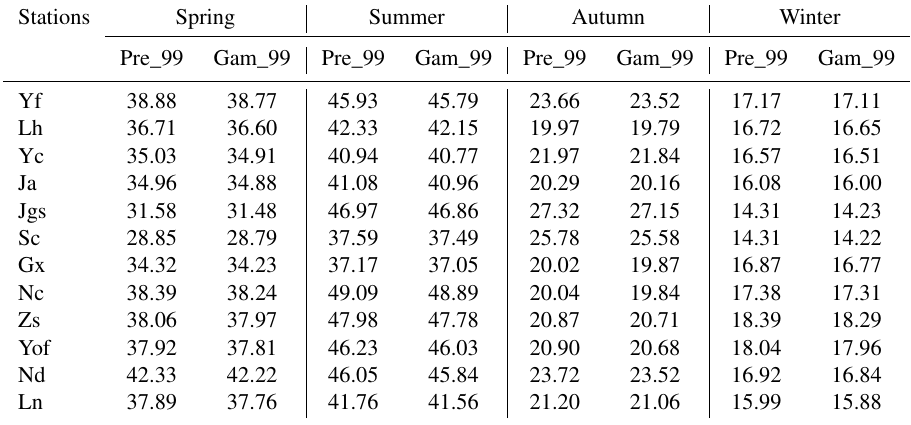
Table 5. Mean threshold values (mm) of 12h in each station and seasons and their estimates obtained from the gamma distribution according to data in 1959–2016. Pre_99 refers to thresholds from the observed precipitation and gam_99 to the estimates from the gamma